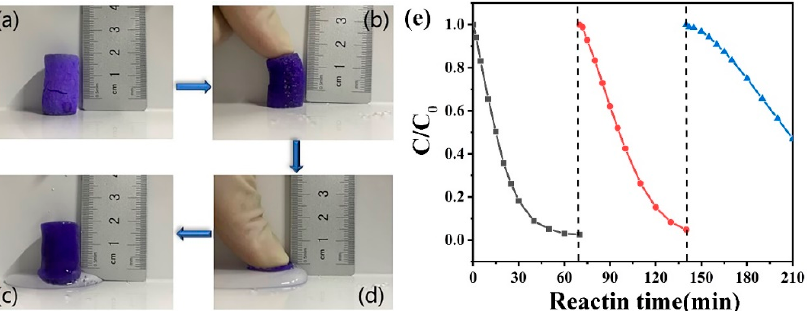
Figure 8. ( a ), ( b ), ( c ), (d) show the process of restoring the water-containing hybrid aerogel to